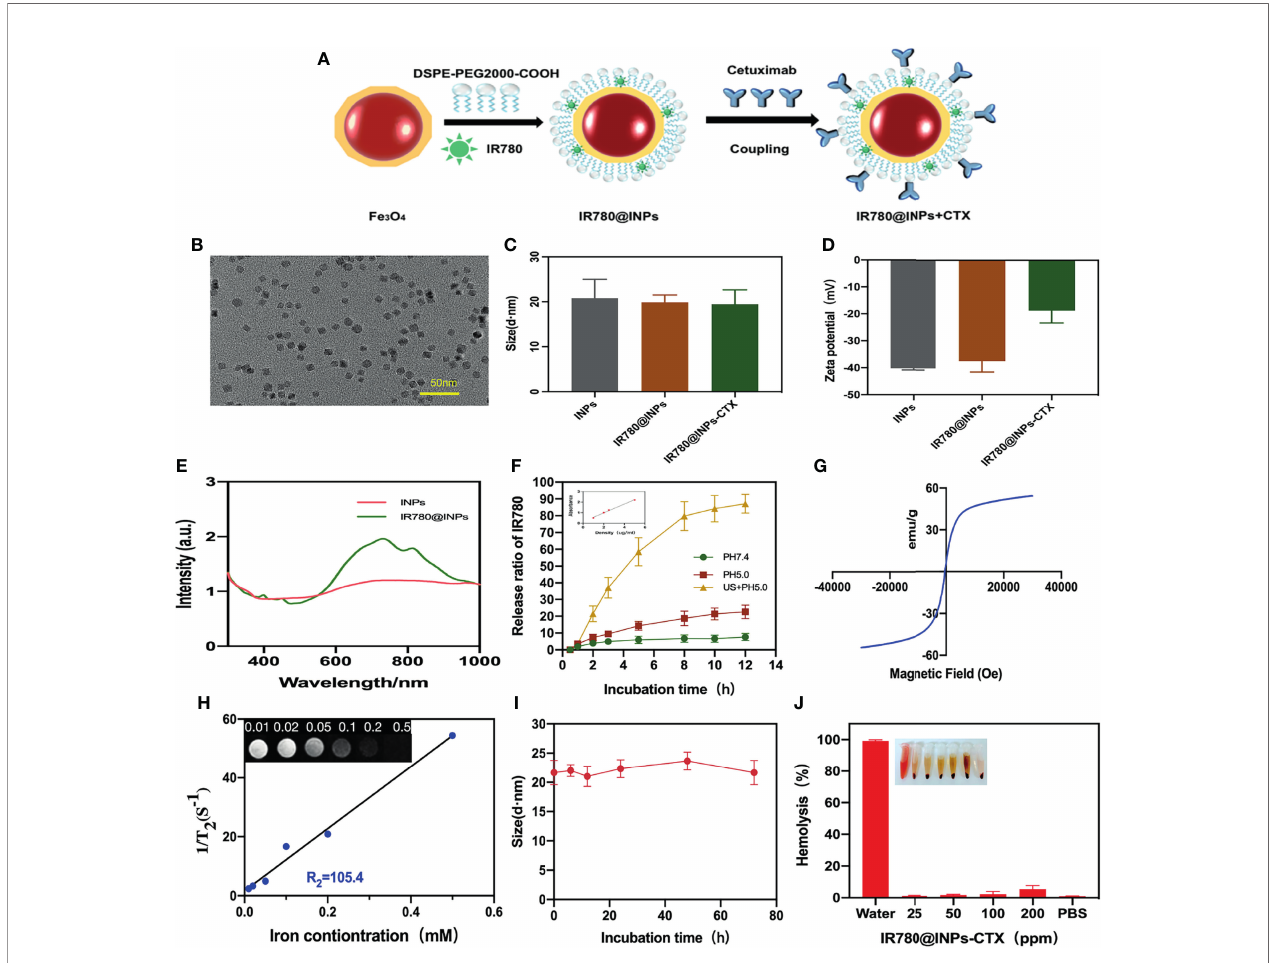
FIGURE 1 | (A) Preparation process of IR780@INPs-CTX. (B) TEM images of INPs. (C, D) DLS and Zeta detection results of INPs loaded with IR780 and CTX. (E) Uv-vis spectrum of IR780@INPs. (F) The release curve of IR780 under different conditions of pH 7.4, pH 5.0 and US + pH 5.0, and the inset is the image of standard curve of IR780. (G) Magnetization curve of IR780@INPs. (H) T2 relaxation rate of IR780@INPs nanoparticles, and the inset is T2-weighted images of IR780@INPs nanoparticles under different iron concentrations (mM). (I) Stability curves of IR780@INPs-CTX in PBS for 0 h, 6 h, 12h, 24h, 48h and 72h. (J) Stability evaluation of IR780@INPs-CTX in